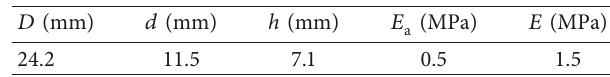
Figure 13: Axial compression experiment of the rubber bush. Table 2: Parameters of the rubber bush.